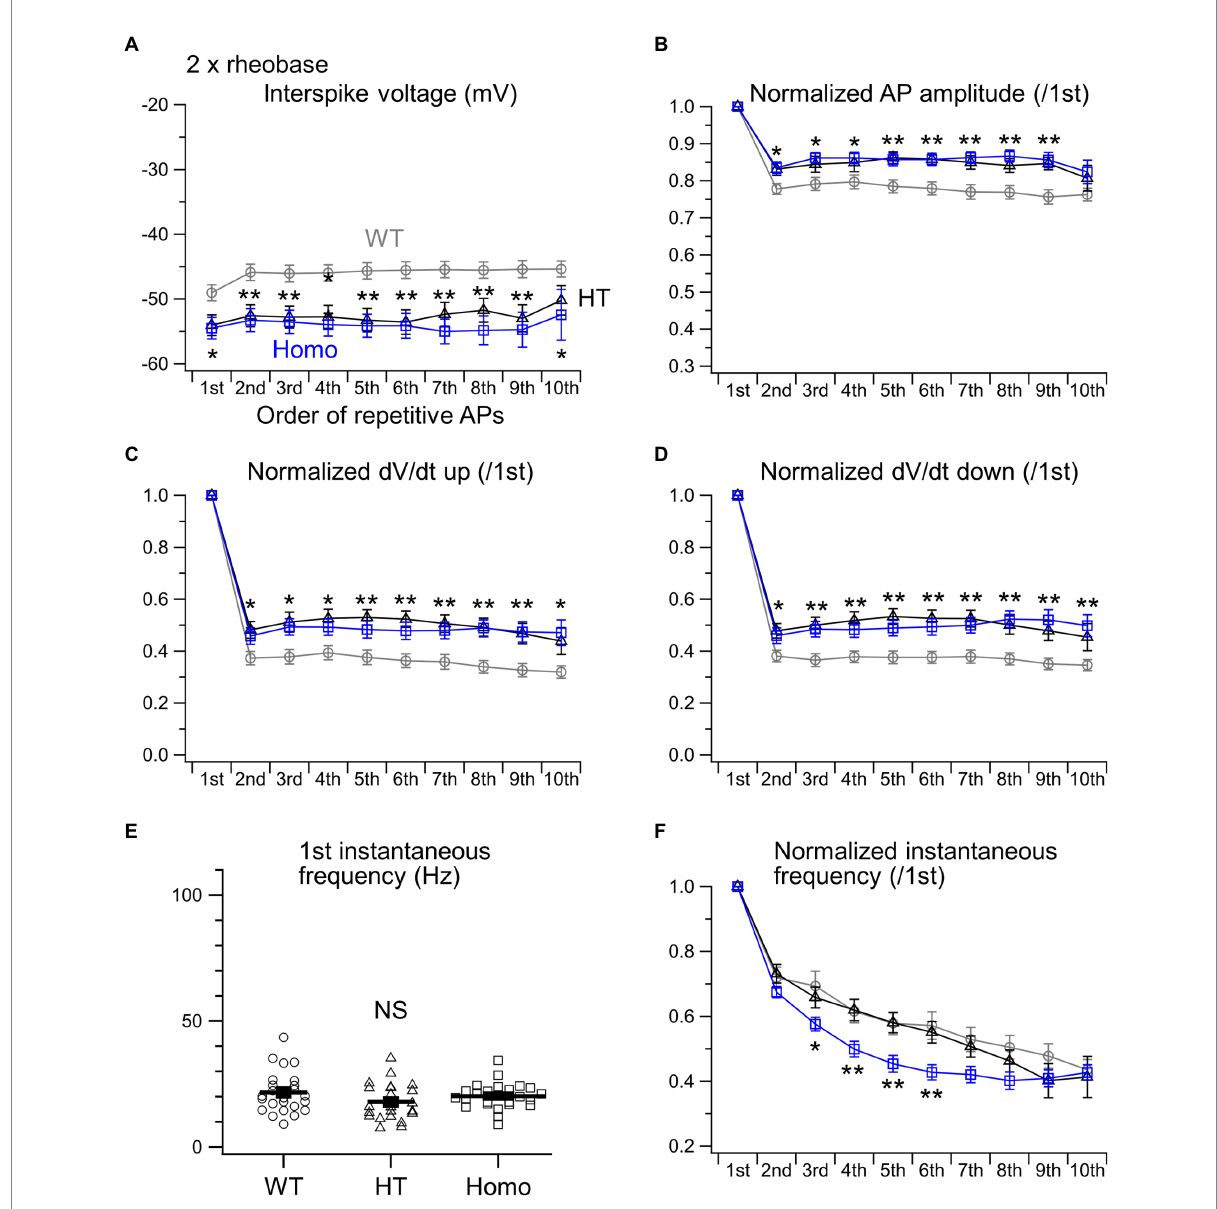
FIGURE 4 Properties of repetitive AP firing induced by 2 × rheobase. (A) Interspike voltage levels were defined as the minimum membrane voltage levels between adjacent AP spikes. The initial 10 interspike voltages were compared between WT (gray), HT (black) and Homo (blue) neurons. (B) The amplitudes of initial 10 APs were normalized to that of the first AP. (C) dV/dt ups of initial 10 APs were normalized to the first. (D) dV/dt downs of initial 10 APs were normalized to the first. * p < 0.05, ** p < 0.01, WT vs. HT and Homo by REGW-F. (E) Comparison of the first instantaneous frequency. Symbols indicate the values in individual neurons, and thick bars with error bars indicate means ± SEMs. WT: 21.7 ± 1.7 Hz, HT: 17.9 ± 1.5 Hz, Homo: 20.2 ± 1.0 Hz, p = 0.184 by ANOVA. NS, not significant. (F) The initial 10 instantaneous frequencies were normalized to the first. * at 3rd, p < 0.05, WT vs. HT and Homo by K-W. ** at 4th, p < 0.01, WT vs. HT and Homo by Dunnett’s T3. ** at 5th, p < 0.01, WT vs. HT and Homo by REGW-F. ** at 6th, p < 0.01, WT vs. HT and Homo by